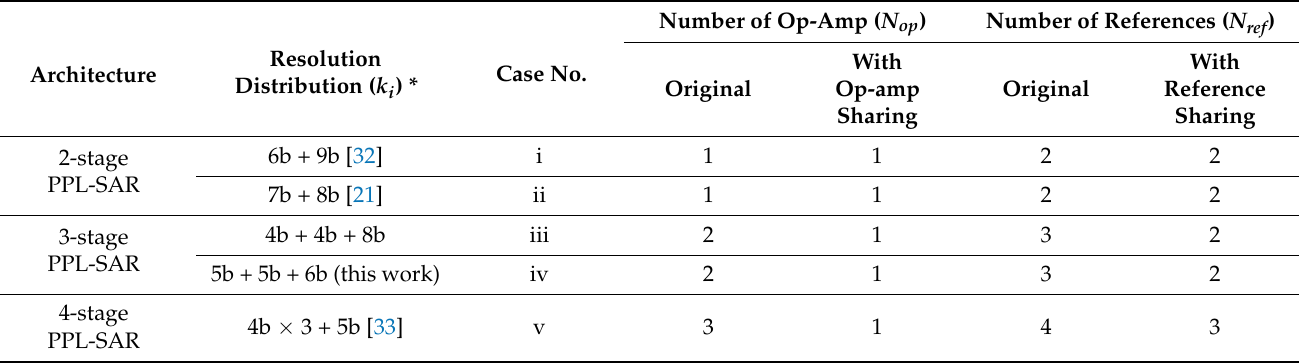
Table 1. Comparison between architectures.